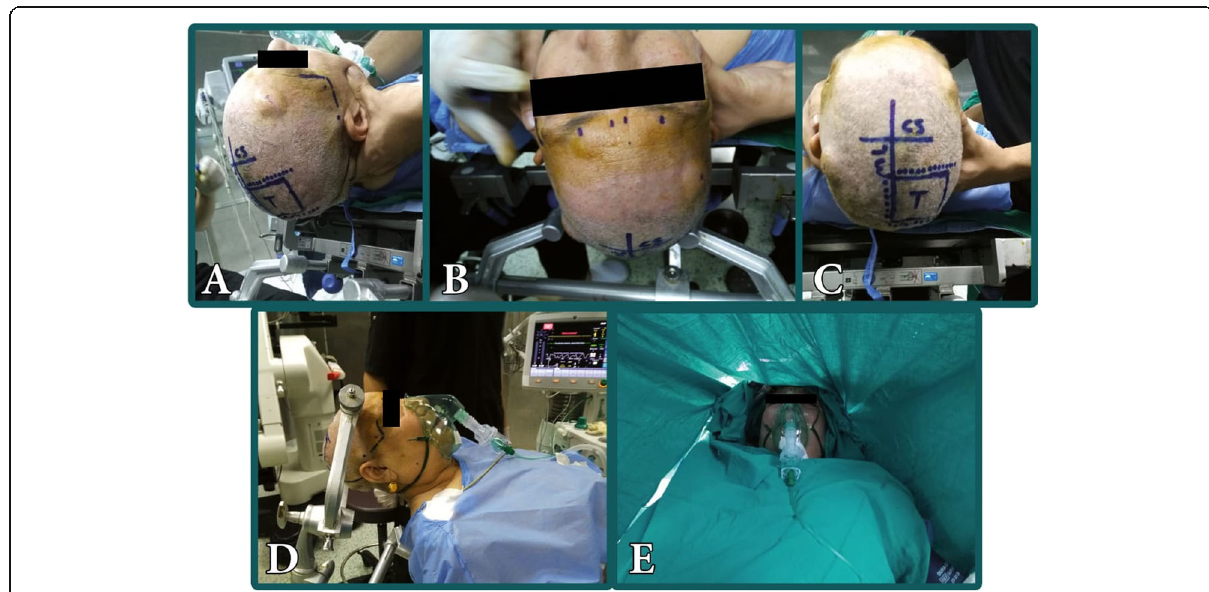
Fig. 1 Patient positioning and scalp blockade with local anesthetic. A , B Sites of scalp infiltration with local anesthetic. C Tumor localization and